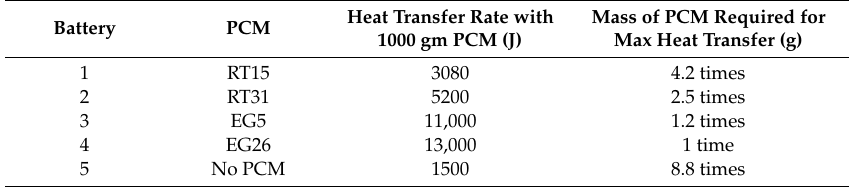
Table 5. Comparison of mass of PCM required during discharge on a single pouch battery.